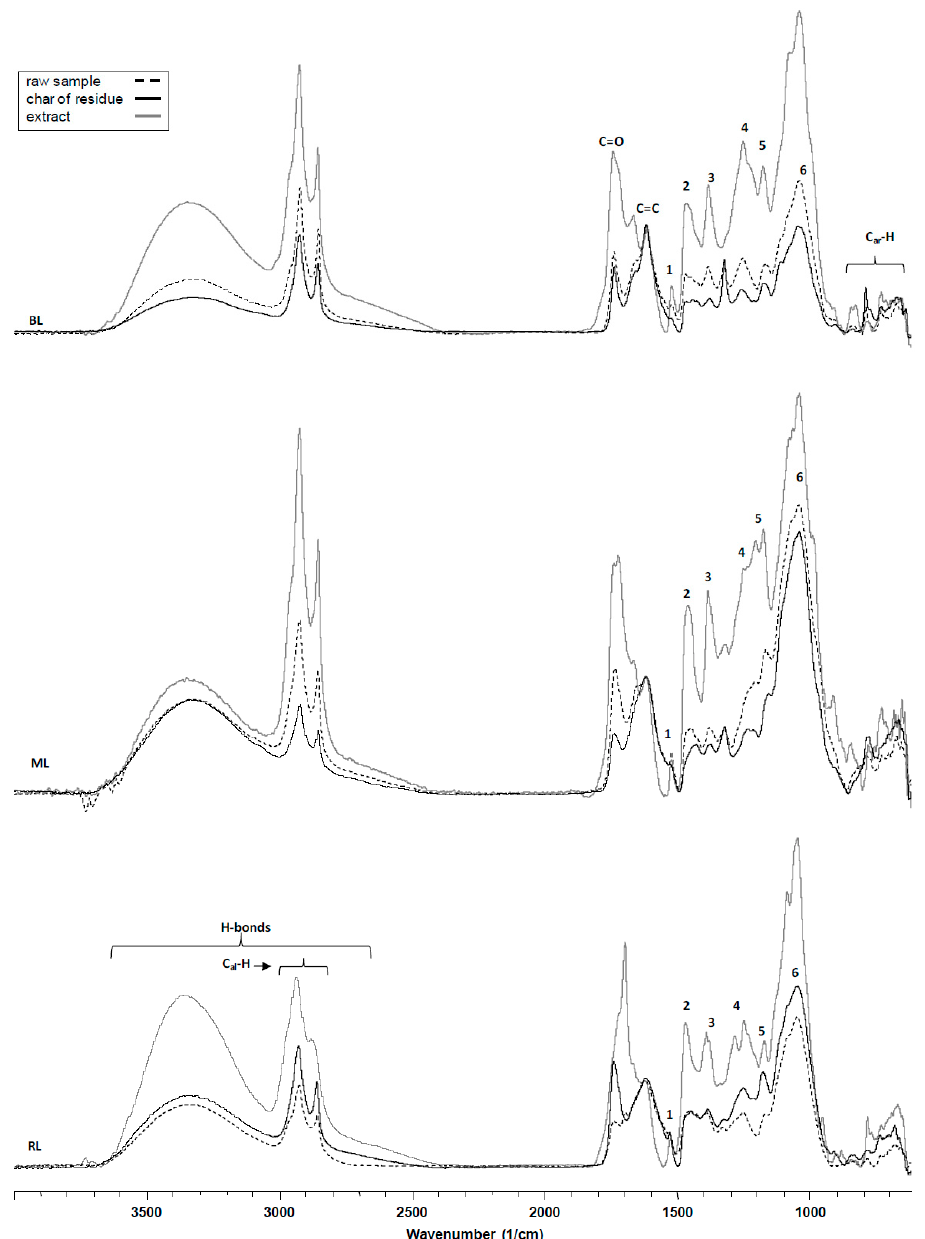
Figure 4. ATR spectra of examined samples and their extraction products—extracted and residual materials: (1) aromatic skeletal vibrations of guaiacyl rings; (2) pyran ring symmetric scissoring C-H deformation, asymmetric in plane for lignin and hemicellulose; (3) C-H deformation in hemicellulose; (4) guaiacyl ring breathing, C-O stretch in lignin, C-O linkage in guaiacyl aromatic methoxyl groups; (5) C-O-C stretching vibration ring skeletal pyranose; (6) C-O stretching in cellulose and C-O deformation [31–33,36].